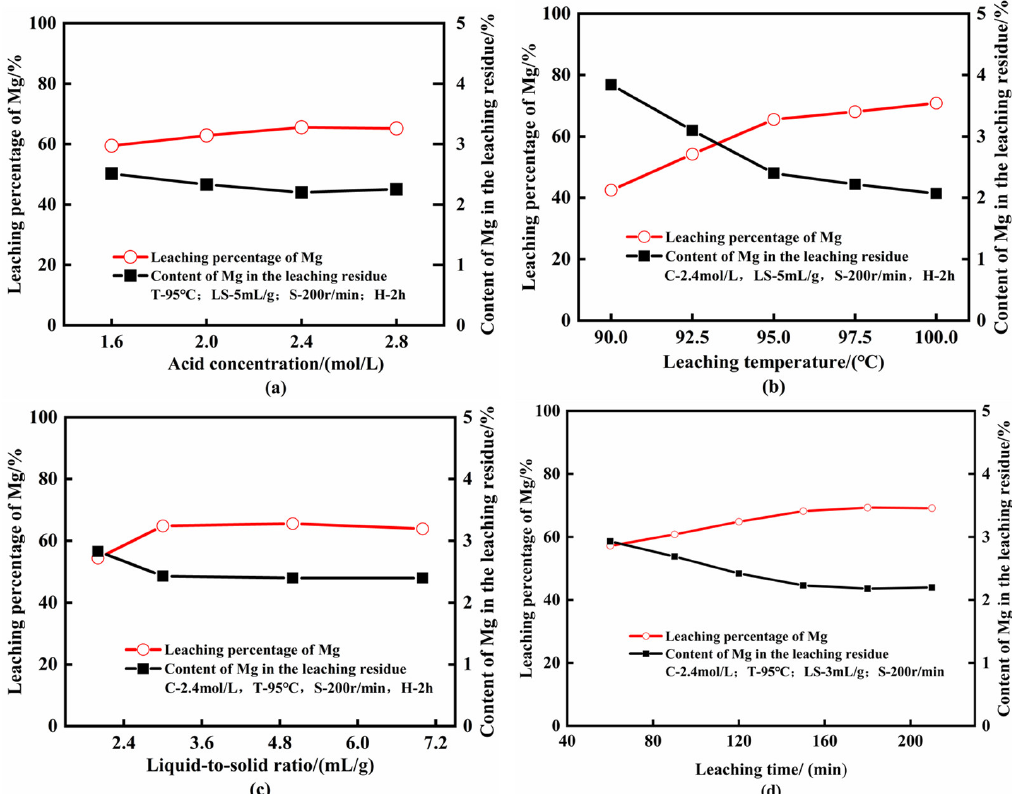
Figure 4. Influence of the main factors on the leaching rate of Mg in secondary acid leaching ( a ) acid concentration; ( b ) leaching temperature; ( c ) liquid-to-solid ration; ( d ) leaching time.